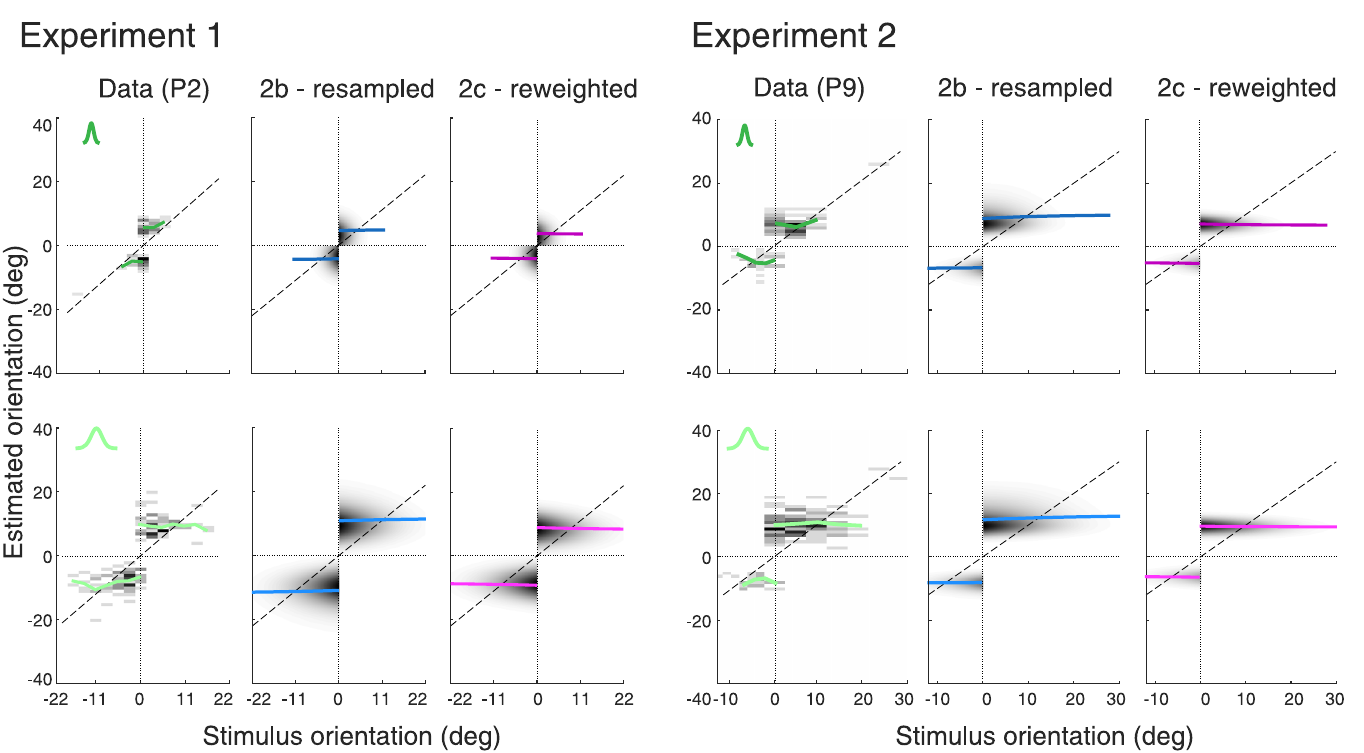
Fig 10. Predictions of Models 2b (resampled) and 2c (reweighted). Both model variants provide good predictions of the estimate distributions in incorrect trials of subject P2 (Experiment 1) and P9 (Experiment 2), respectively. Compared to Model 2a, the predicted mean estimates (solid lines) are larger and more accurately reflect the data. Note that Model 2b predicts a weak positive dependence between the mean estimate and true stimulus orientation, which may reflect a tendency in the data although with no significance (see S2 and S4 Figs for all other subjects). Model 2c predicts a weak negative dependence.